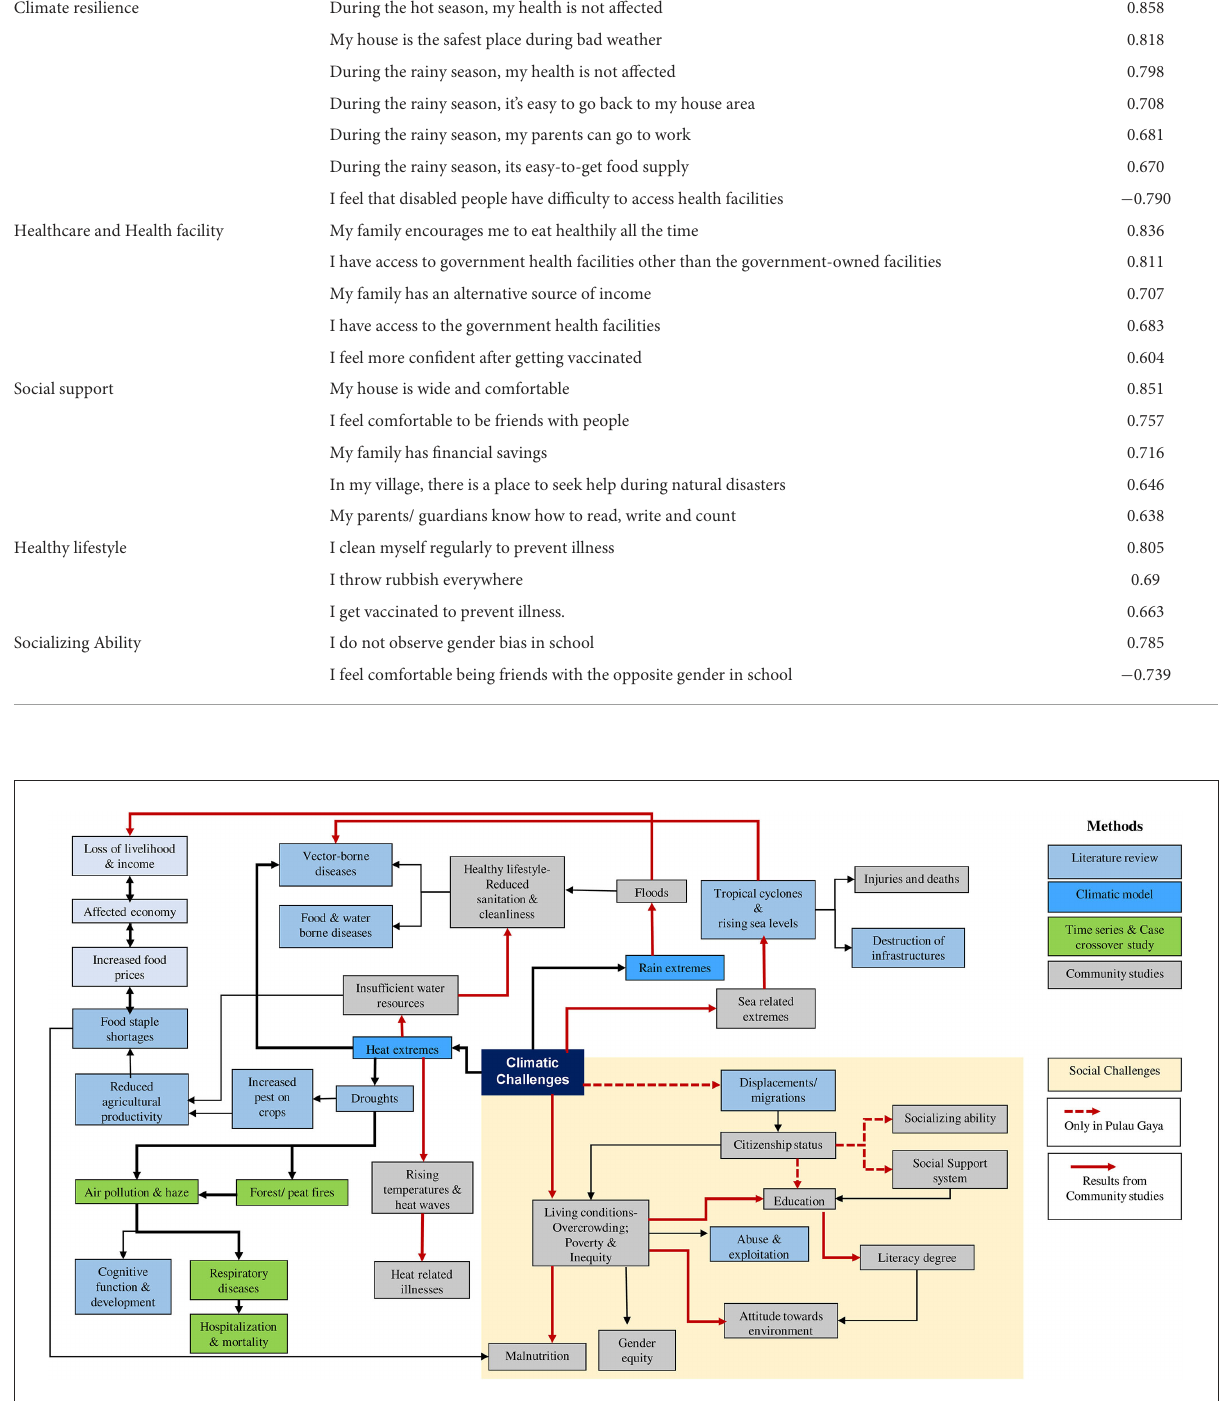
FIGURE9 Model of the impacts of climate change on children in